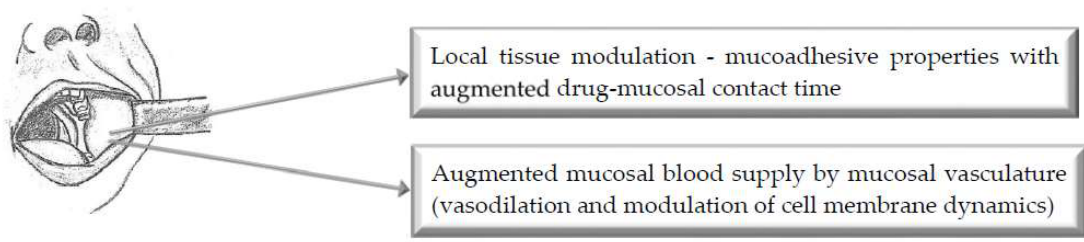
Figure 1. Illustration of the main mechanisms of action of bioenhancers for enhanced buccal drug delivery.